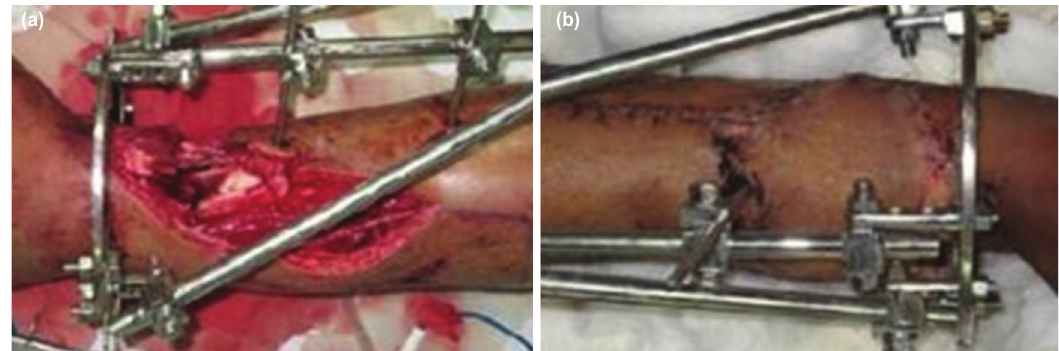
(a,b) Grade 3B (43A3 – Complex Distal Extra-articular) open tibia fracture managed by external fixation and distant free muscle Fig. 2: flap (Anterolateral Thigh) in the same